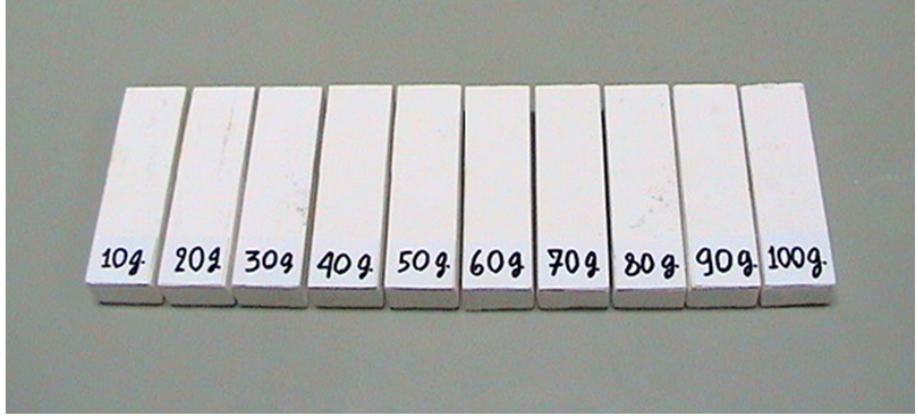
Figure 10. Calcium phantom.